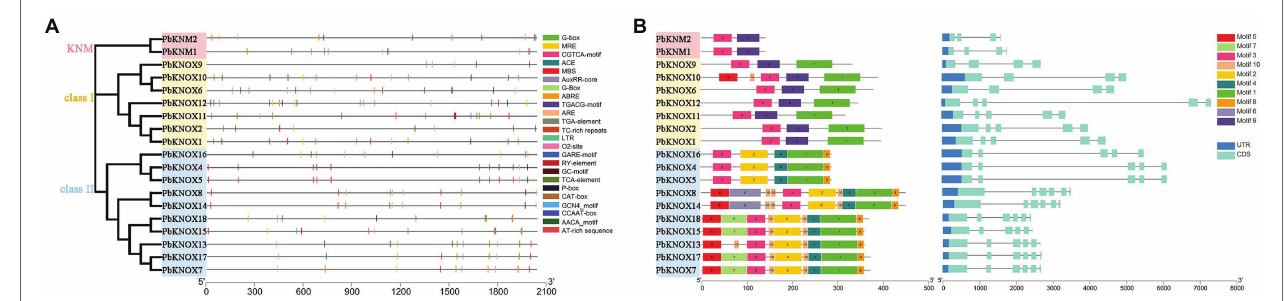
FIGURE 3 | A list of motifs detected in the promoter regions of PbKNOX genes (A) . Schematic representation of protein and gene structures of Pyrus bretschneideri PbKNOX genes (B) . Motifs 1–10 identified using the MEME search tool are marked on the protein sequences in each clade (1–3). The length and order of each motif correspond to the actual length and position of each motif in the protein sequences, respectively. The coding sequence and untranslated regions are represented by filled dark blue and orange boxes, respectively. Evolutionary analysis shows the homology of PbKNOXs in